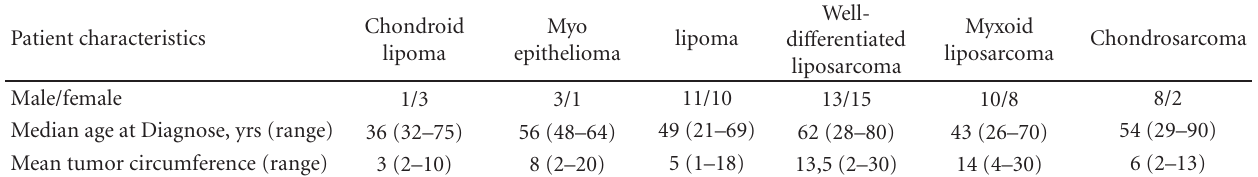
Table 1: Patient and tumor characteristics.